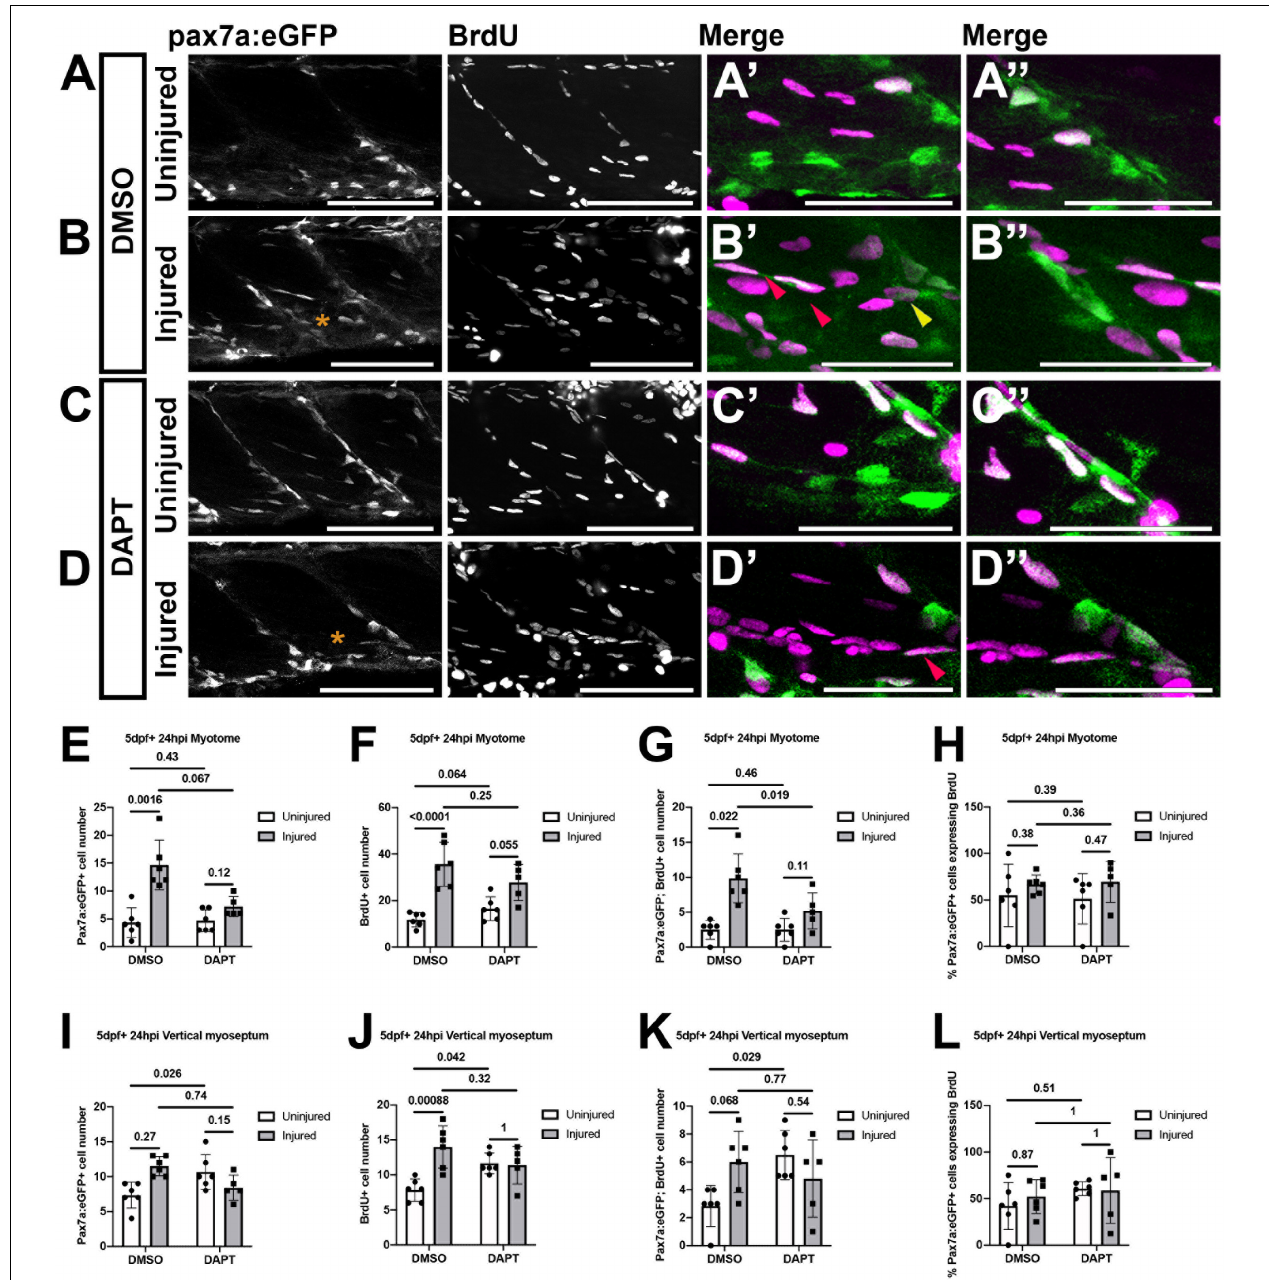
FIGURE 5 | Proliferation of muSCs during regeneration and homeostasis is Notch dependent. Projections of confocal stacks (A–D) of the myotome (A’–D’) and vertical myoseptum (A”–D”) in uninjured (A,C) and injured (B,D) 5 dpf pax7a:eGFP larvae incubated with BrdU for 24 h. Larvae were treated with 1% v/v DMSO (A,B) or 100 µ M DAPT (C,D) after injury and detection of BrdU and eGFP was performed by immunolabeling. MuSCs with (red arrowheads) and without BrdU labeling (yellow arrowheads) are recruited to the injury (asterisk) site (B’,D’) . The number of cells expressing pax7a:eGFP (E,I) , incorporating BrdU (F,J) or both (G,K) were counted in the myotome (E–G) and both vertical myoseptum (I–K) of animals treated with DMSO or DAPT. The proportion of pax7a:eGFP-expressing muSCs incorporating BrdU was calculated for both myotome (H) and vertical myoseptum (L) . There were significantly fewer GFP+ muSCs incorporating BrdU after injury in the presence of DAPT compared to DMSO treated control animals ( p < 0.05; G ). There is no significant change to the number of GFP+ muSCs incorporating BrdU at the vertical myoseptum of injured animals in the presence of DAPT ( p > 0.05; K ). In contrast, although there are only few cells present, there is a significant increase in the number of muSCs with BrdU labeling at the myoseptum in uninjured animals in the presence of DAPT ( p < 0.05; K ). Significant differences were tested by 2-way ANOVA ( n = 23) with Tukey’s HSD post hoc test or by transforming data by ART and performing 2-way ANOVA followed by a Dunn’s test with Benjamini and Hochberg correction. Error bars display standard deviation, and values above comparison bars indicate significance ( p -values). Scale bars: 100 µ m (A–D) , 50 µ m (A’–D’,A’–D”) .